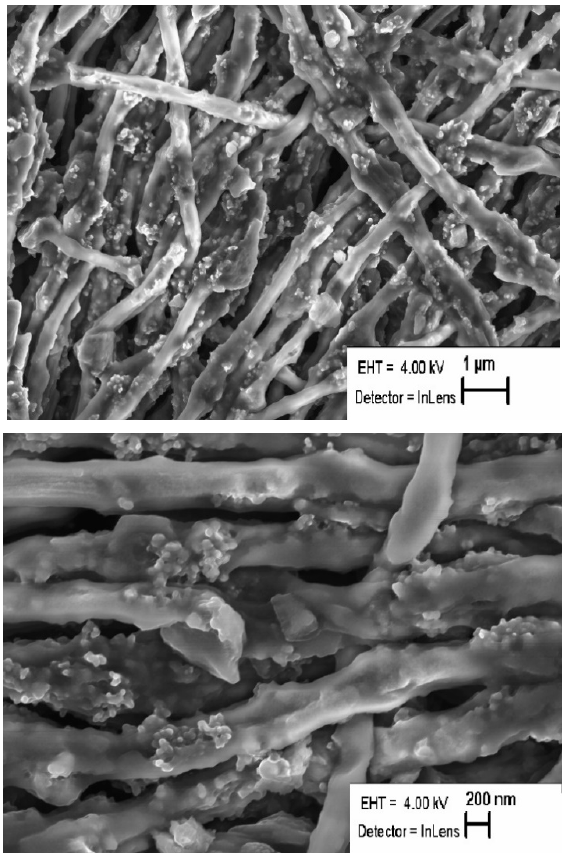
Figure 1. Different magnifications of scanning electron microscope (SEM) images of electrospun carbide-derived carbon (CDC) based fibrous electrode.